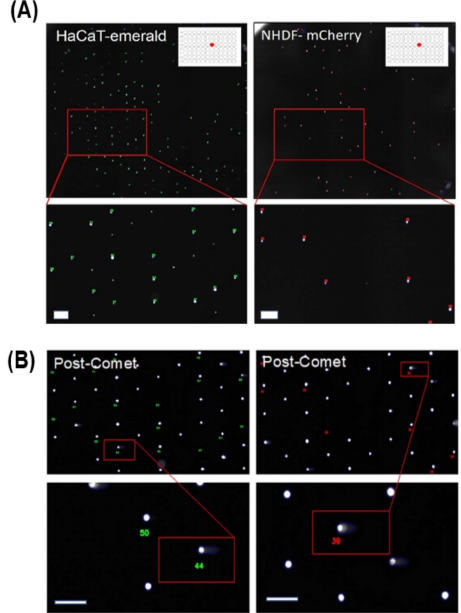
Figure 4. Representative images of dual-cell-type loaded well. ( A ) Pre-Comet mEmerald-labeled HaCaT and mCherry-labeled fibroblasts, were loaded into a single CometChip macro-well (upper images). Cell position was registered (lower images), and cells were identified using numbering before the CometChip was exposed to lysis and alkaline treatment. ( B ) Post-comet processing of CometChip shows the position of the differentially labeled fibroblasts and keratinocytes after comet protocol. In the image, fluorescence is SYBR Green DNA staining. The lower images show the registration of the cells and the blue outline around the cells shows the extent of the comet tail. Scale bar = 100 µ